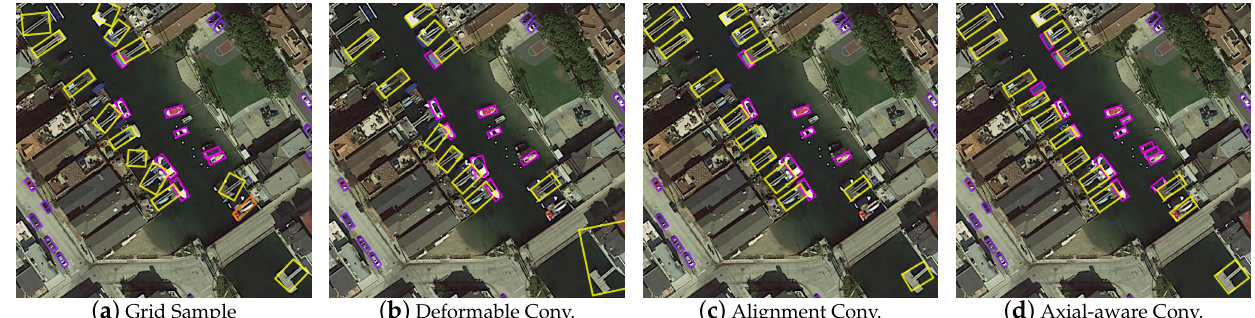
Figure 7. Visualization of different feature alignment methods.